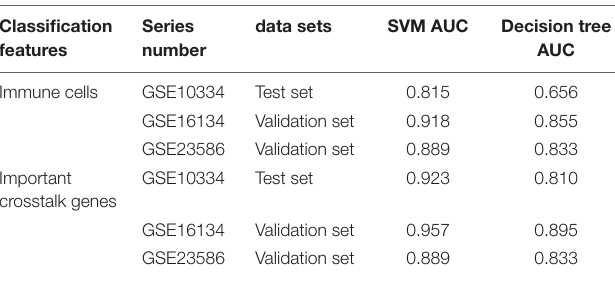
TABLE 3 | Comparison table of performance evaluation of two classifiers